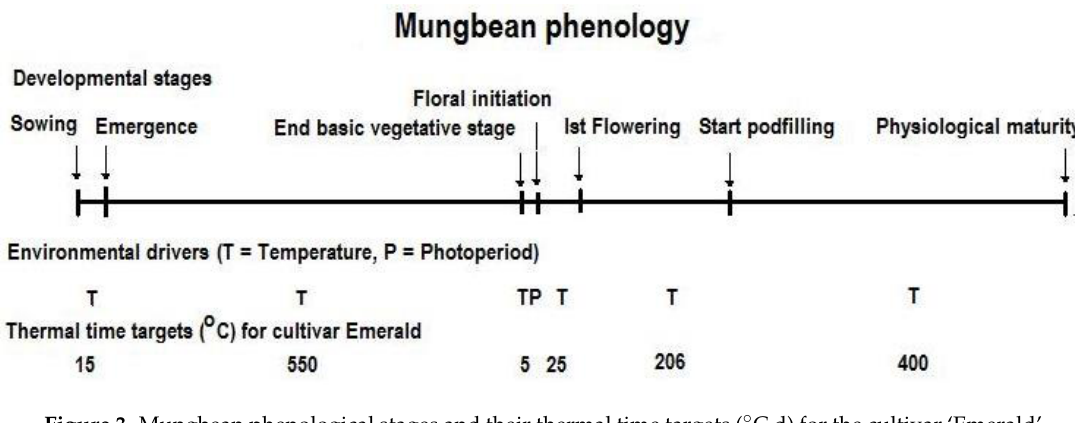
Figure 3. Mungbean phenological stages and their thermal time targets (°Cd) for the cultivar ‘Emerald’. The thermal time target for ‘Crystal’ is similar to ‘Emerald’. The total duration of 1200 °Cd is the sum thermal time targets of all stages.